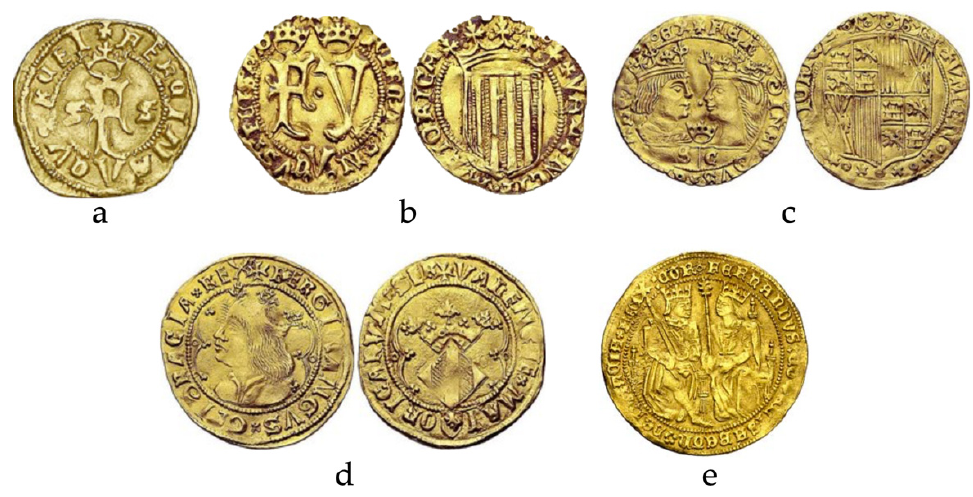
Figure 1. Coins of Fernando I. ( a ). Ducat of Valencia, with F, obverse; ( b ). Ducat of Valencia, with F and Y crowned, obverse and reverse; ( c ). Doble ducat or Excelente of Valencia, obverse and reverse. All from https://www.numisbids.com/n.php?p=sale&sid=359&cid=10127 (accessed on 20 October 2021); ( d ). Doble ducat , obverse and reverse.